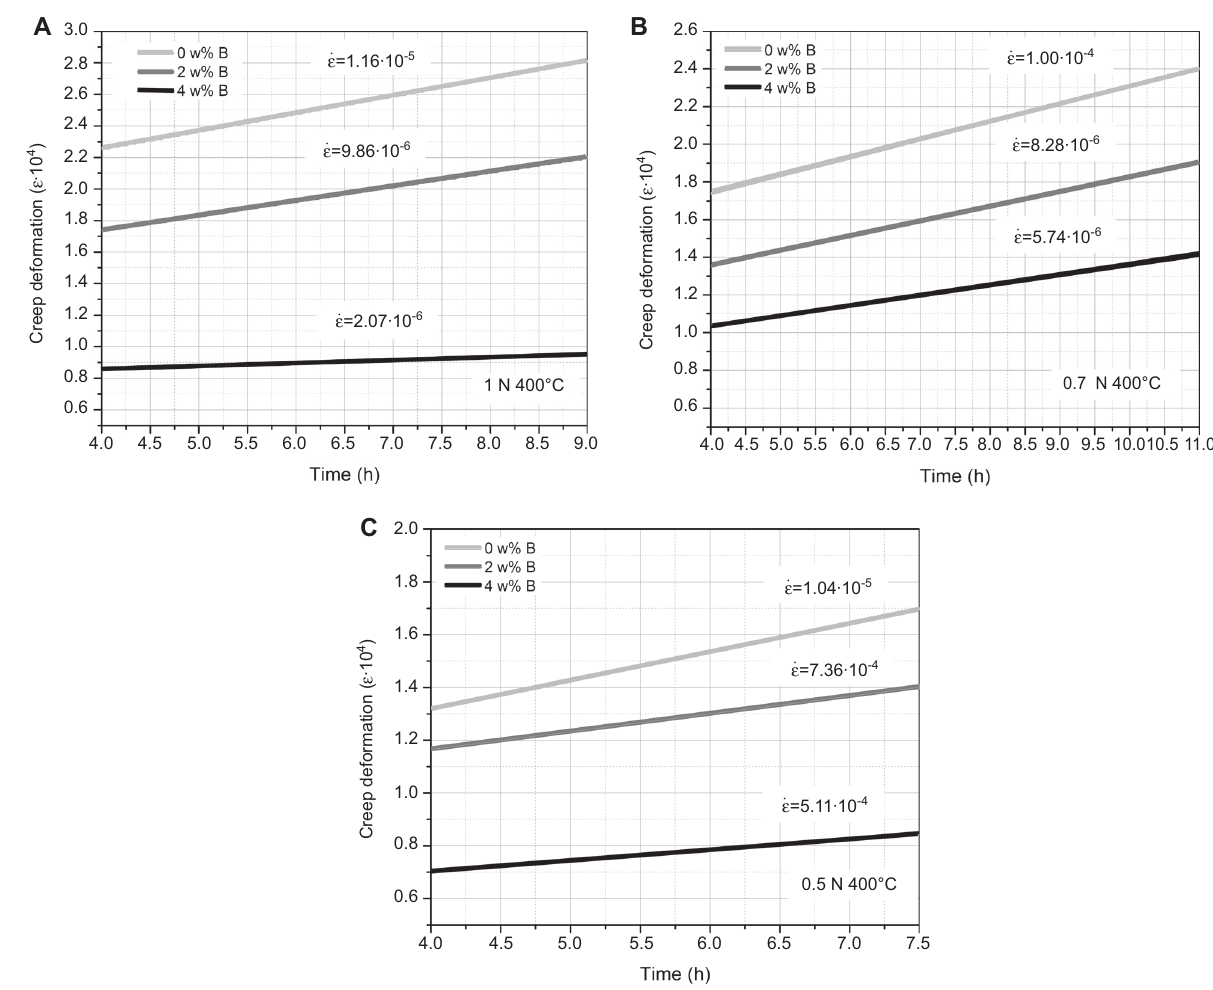
Figure 6 Secondary creep rate curves of Al-Cu reinforced with diboride particles at 400 ° C and different loads: (A) 1 N, (B) 0.7 N, (C) 0.5